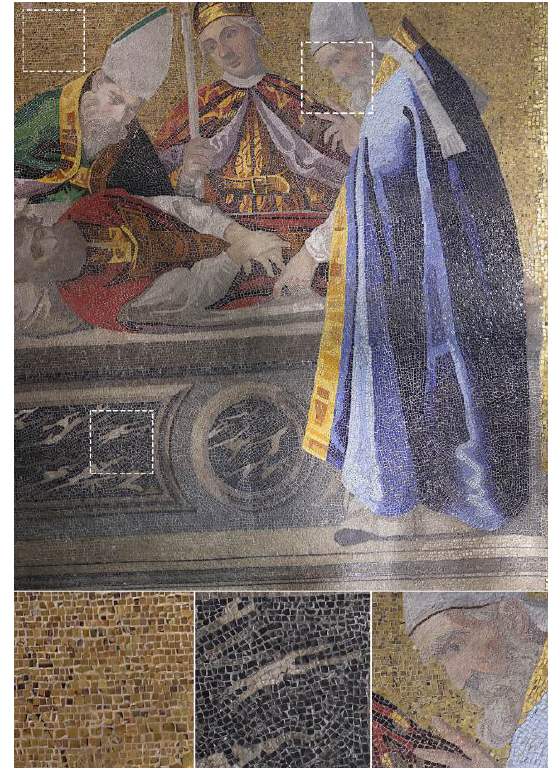
Figure 5: Orthophoto with some details that show different tessera sizes and disposition in the same